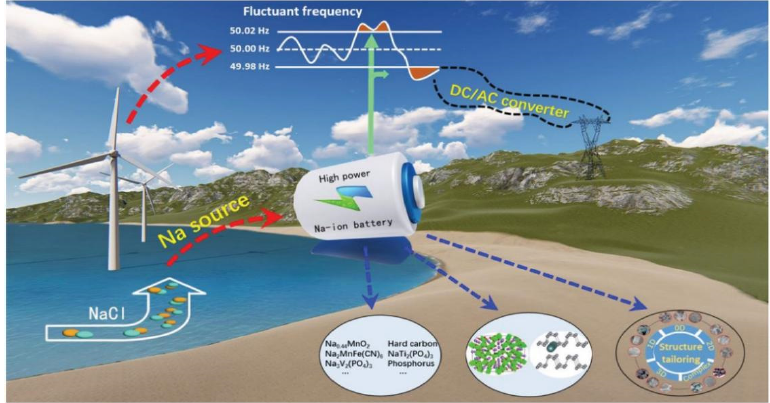
Figure 1. The blueprint of SIBs used in the high-power energy storage system. Reproduced with permission [4]. Copyright 2019, Wiley-VCH.